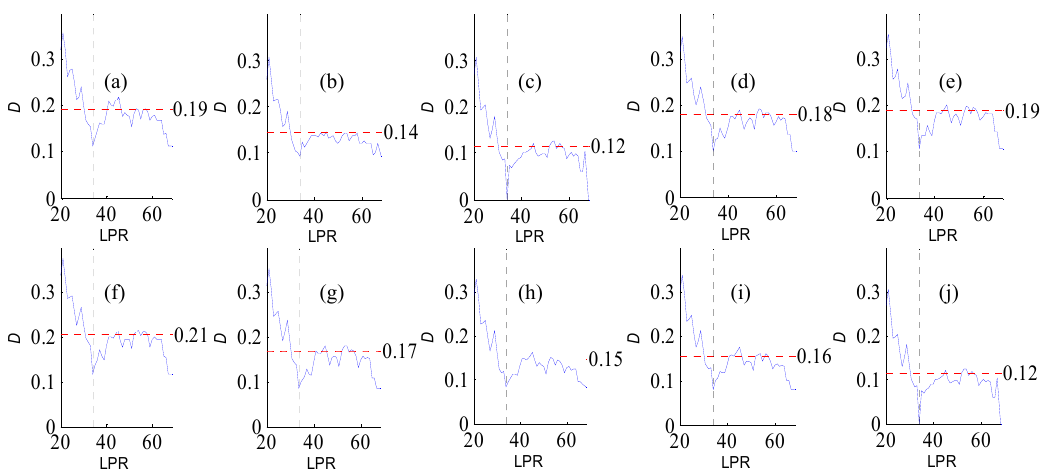
Figure A18. Variation of flow regime alteration degree (D) measured by the RVA with change in the length of post-impact flow time series (LPR) under a periodicity of 33 years. ( a ), ( b ), ( c ), ( d ), ( e ), ( f ), ( g ), ( h ), ( i ), and ( j ) correspond to pre-impact flow time series length = 24, 28, 33, 38, 42, 47, 52, 57, 61, and 66 years, respectively. The abscissa value for the vertical dotted line is 33. The ordinate value for the horizontal dotted line is the mean degree of flow regime alteration in each subfigure.